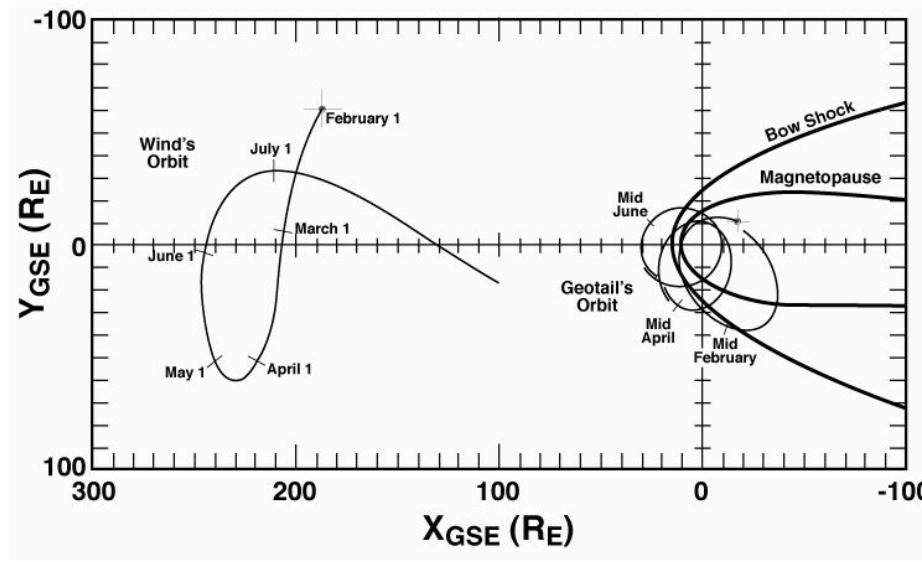
Fig. 1. Wind orbit from February through July 1995 and example Geotail orbits in mid February 1995, mid April 1995 and mid June